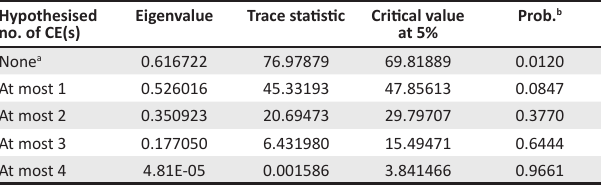
TABLE 3: Johansen cointegration test.